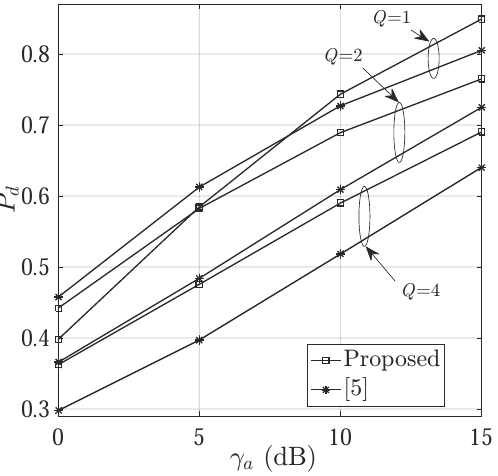
Figure 4. P d versus γ a ( M = K = 8 and T = 16).